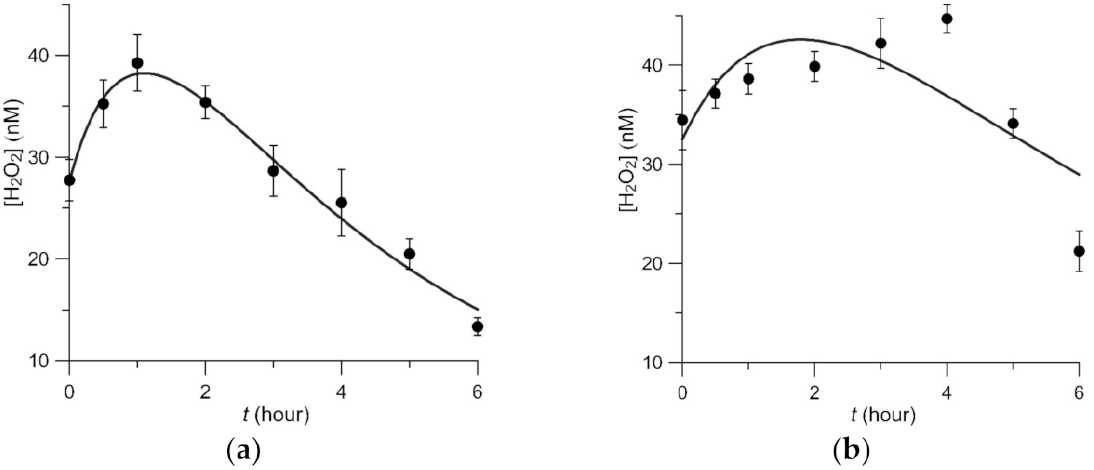
Figure 4. Dynamics of hydrogen peroxide generation in solutions of proteins exposed to heat (45 ◦ C, 2 h) in phosphate buffer (10 mM Na 2 HPO 4 and 150 mM NaCl, pH 7.4): ( a ) BGG (2 µ M); ( b ) BSA (10 µ M). The circles are experimentally measured H 2 O 2 concentrations. The solid lines display theoretical approximation of the experimental points by Levenberg–Marquardt method.